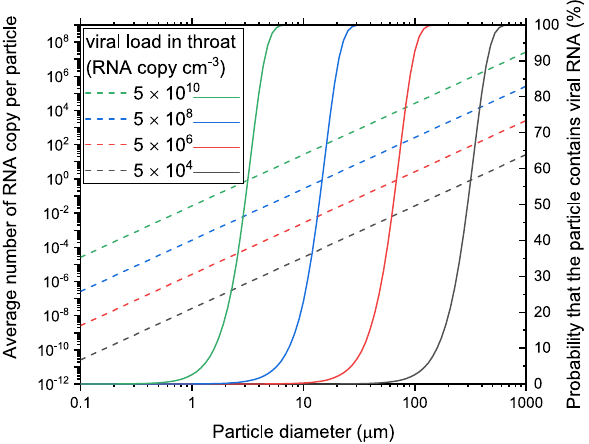
Figure 5. The average number of RNA copies of the virus in one particle (left axis and dash lines) and the probability that a particle contains at least one RNA copy (right axis and solid lines) as the function of particle size in case of different initial viral loads (in RNA copy per cm 3 ) in the throat (different